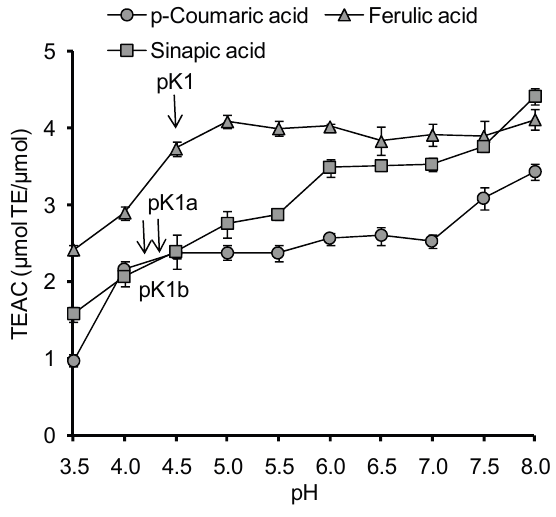
Figure 4. pH-Dependence of AOC against the ABTS radical cation for HC acids (pK1a is sinapic acid related, pK1b is p-coumaric acid